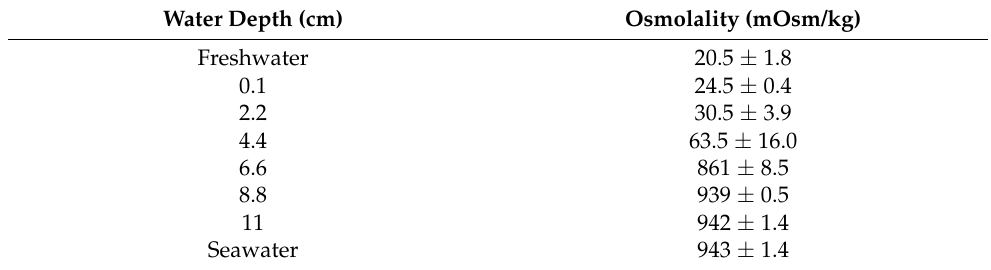
Figure 1. A picture of a simplified system for salinity preference experiments. View of the preference aquarium consisting of a freshwater area (upper, left: colorless, right: blue-colored water) and seawater area (lower, left: blue-colored water, right: colorless). Table 1. Water osmolality in simplified salinity preference system at the beginning of the experiment.